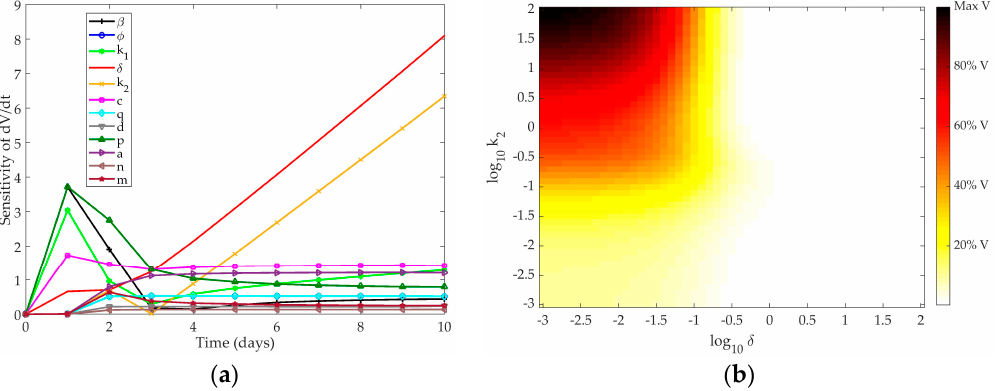
Figure 3 Figure 3. ( a ) Time-dependent sensitivity of virus to each parameter in the Saenz model; ( b ) Two-dimensional sensitivity of the Saenz model to the two most sensitive parameters: k 2 and δ . Colors correspond to the amount of virus present at ten days post-infection in simulation as a fraction of the maximum virus concentration observed. Darker colors correspond to a higher level of virus present at day 10, while lighter colors indicate a low level of virus present in the system after ten